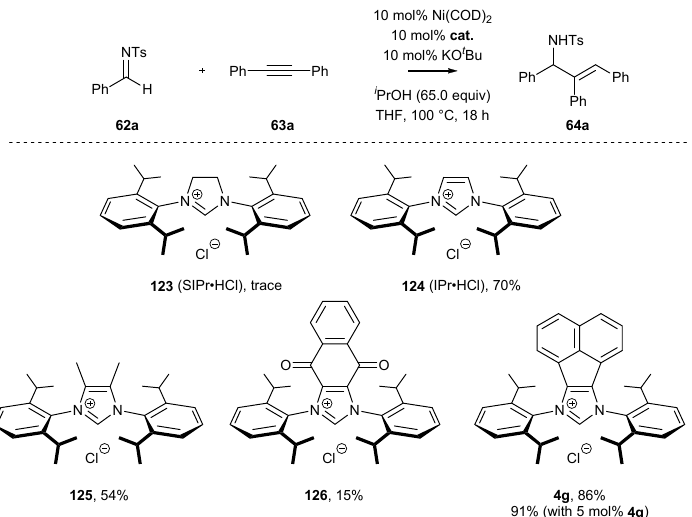
Scheme 53. Influence of backbone modification of NHC ligands on the reductive coupling of alkynes with